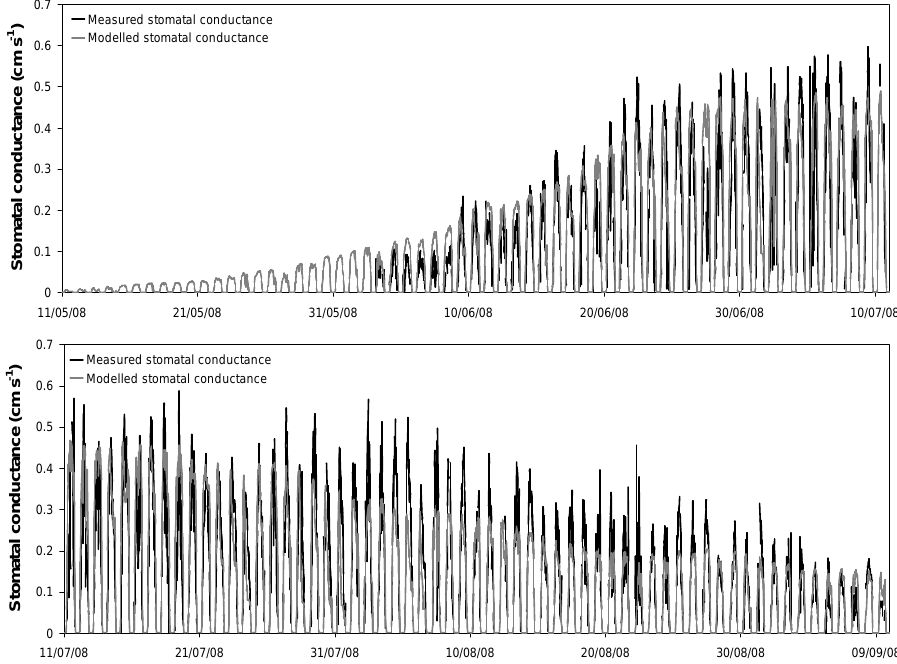
Figure 5: Time series of stomatal conductance deduced from measurements (black line) and modelled stomatal conductance for green leaves (grey line) for the Grignon site. 19